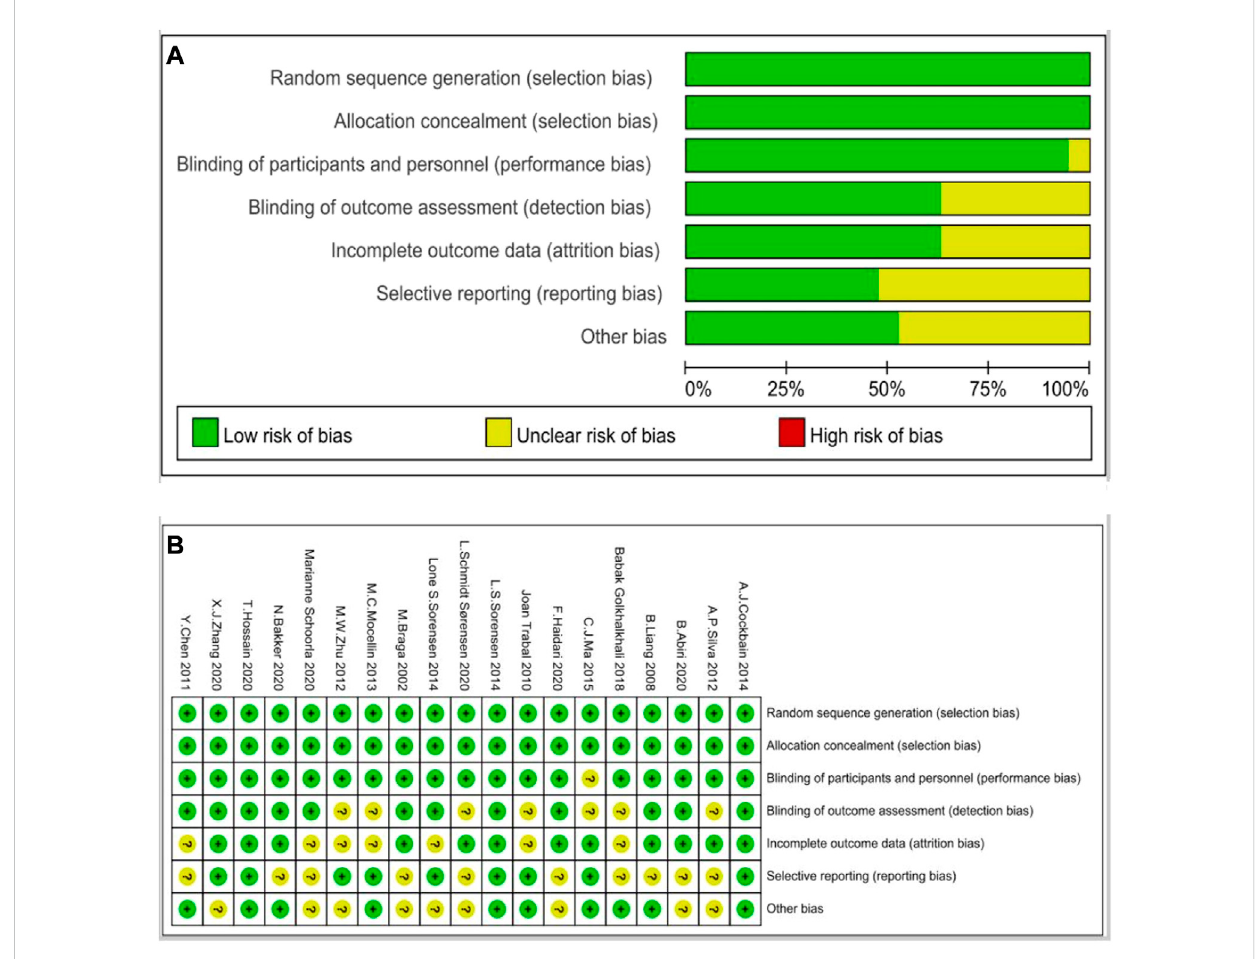
FIGURE 2 Risk of bias graph of RCTs (A) ; Risk of bias summary of RCTs (B) .